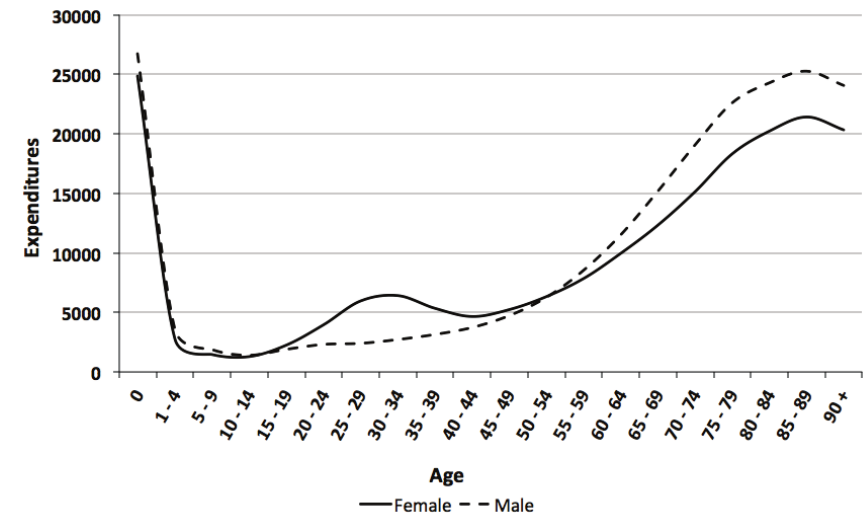
Figure 3: Estimated per capita hospital expenditures by age excluding the effect of